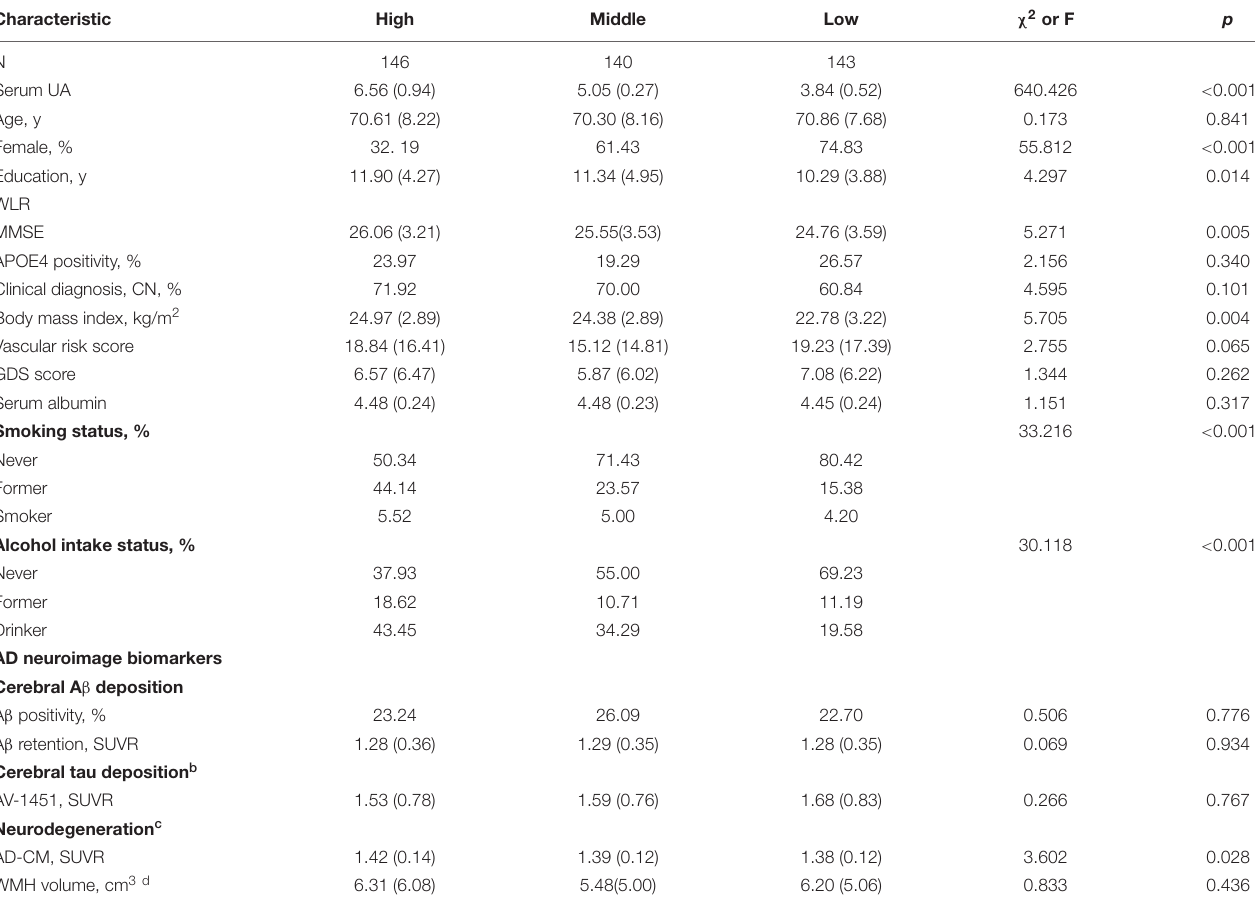
TABLE 1 | Participant characteristics by serum UA strata ( N =